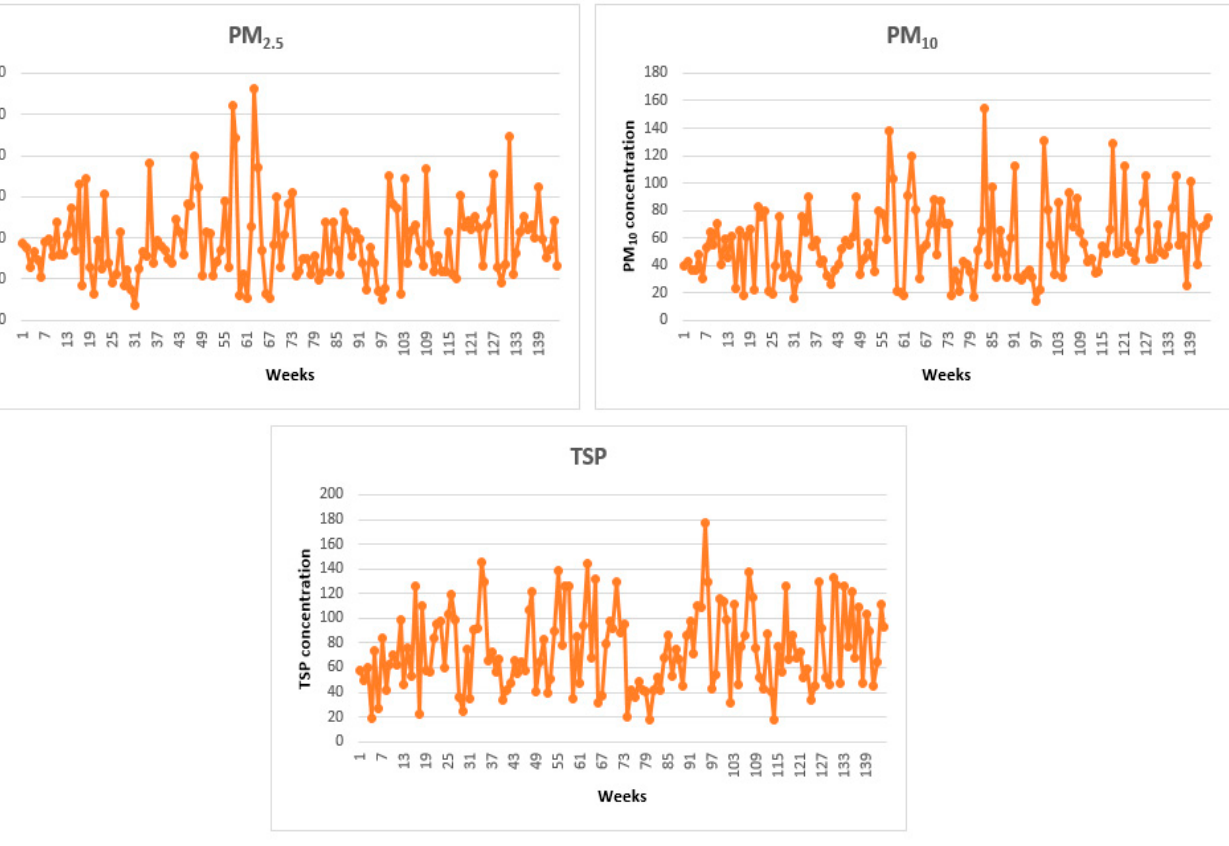
Figure 3. Plots of PM 2 . 5 , PM 10 , and TSP measured